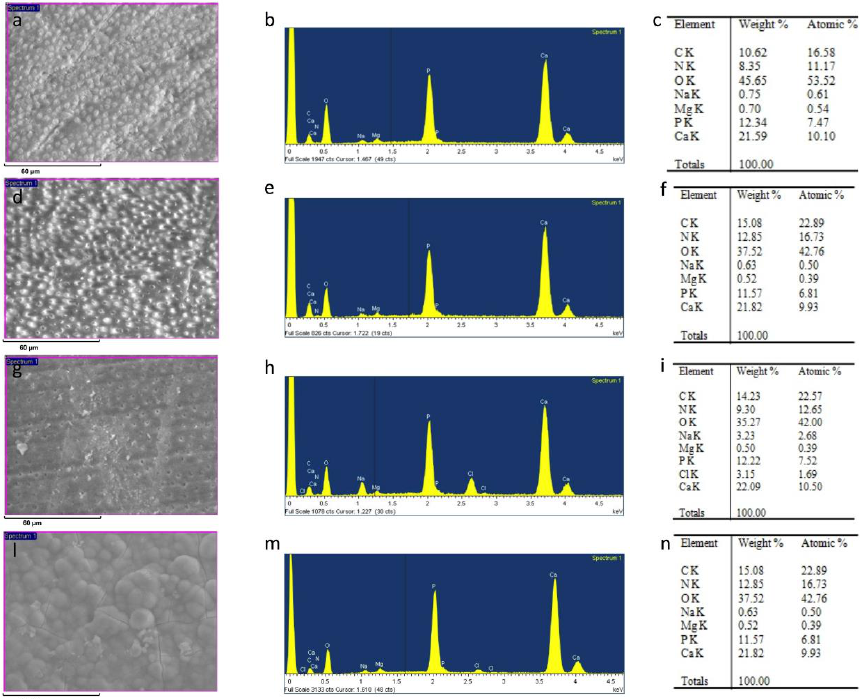
Figure 1. ESEM image, EDX spectra, and table of elements recorded on the dentin surface after sanding with abrasive paper ( a , b , c ), after treatment with a 1% EDTA solution ( d , e , f ), and after immersion in simulated body fluid (SBF) for 24 h ( g , h , i ) and two months ( l , m , n ). Materials 2018 , 11 , x FOR PEER REVIEW